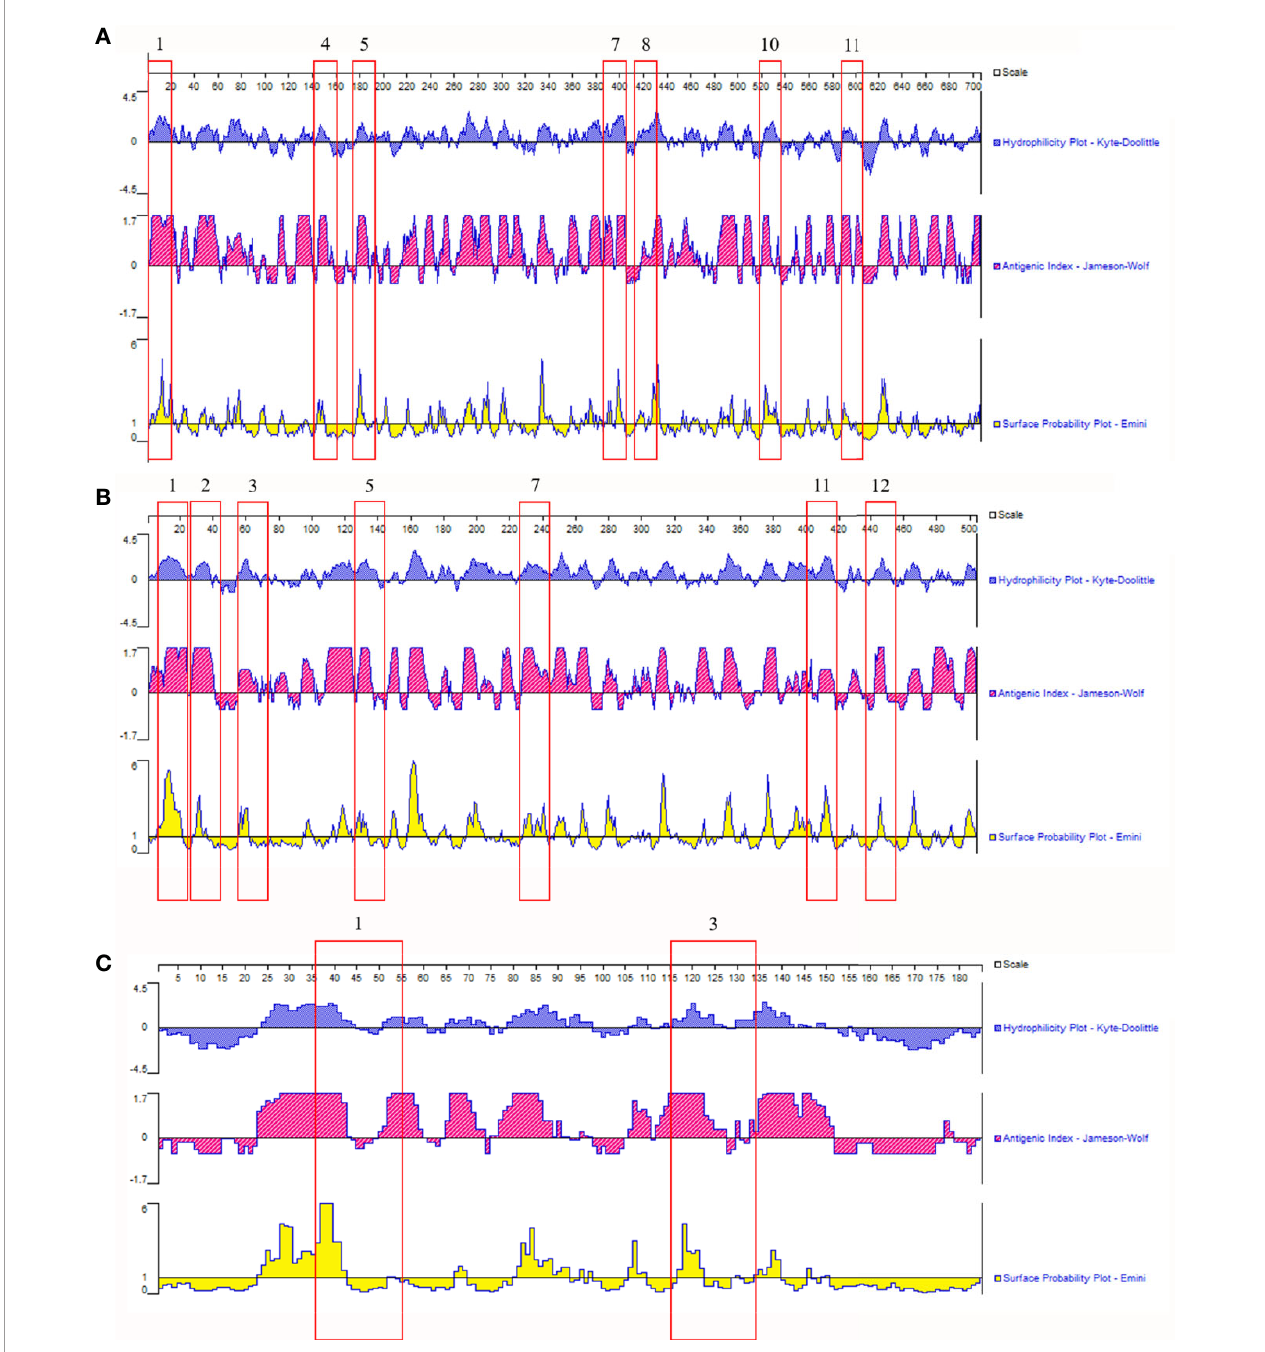
FIGURE 4 | In silico evaluation of putative B epitopes on candidate proteins for antigenic targets for the diagnosis of histoplasmosis. Results obtained from overlapping data from two bioinformatics tools: the software DNAStar Protean 7.0 and BCPREDS server. (A) M antigen; (B) Catalase P; (C) YPS-3. The fl agged numbers refer to the peptides described in Table S7